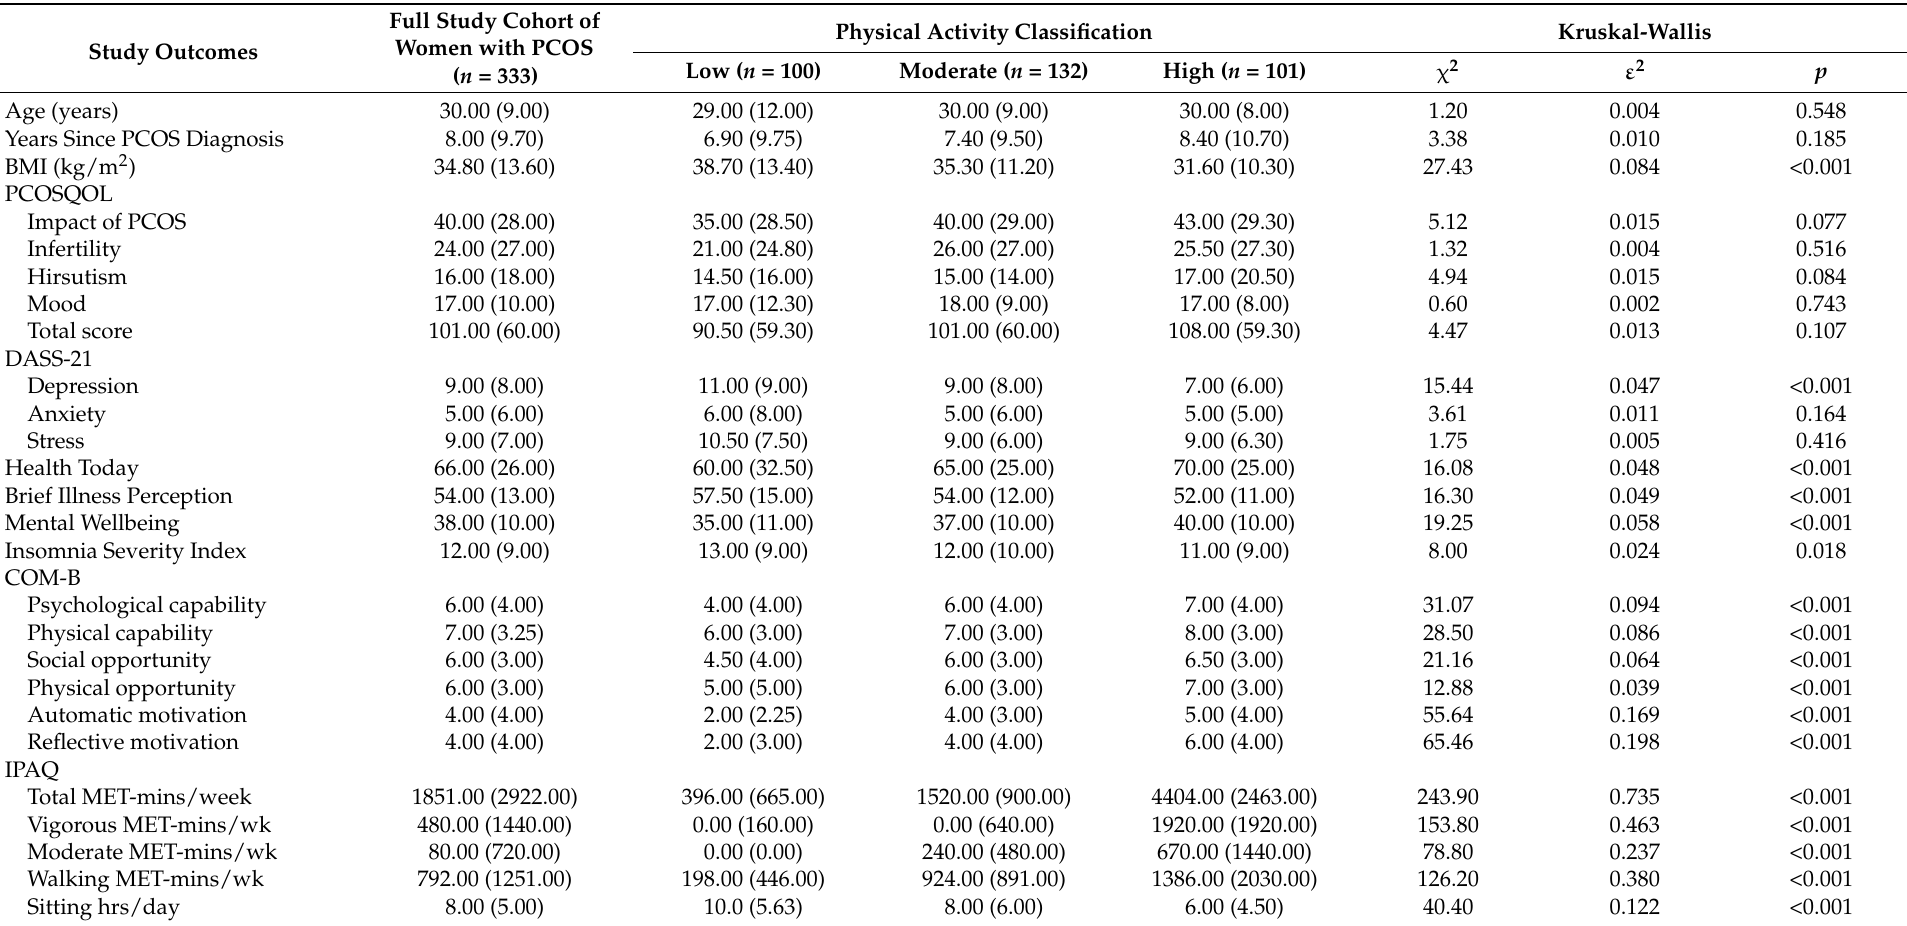
Table 2. Study outcome descriptive statistics (median (IQR)) for the whole study cohort ( n = 333), and also categorised based upon their physical activity classification (low; moderate; high) according to the International Physical Activity Questionnaire